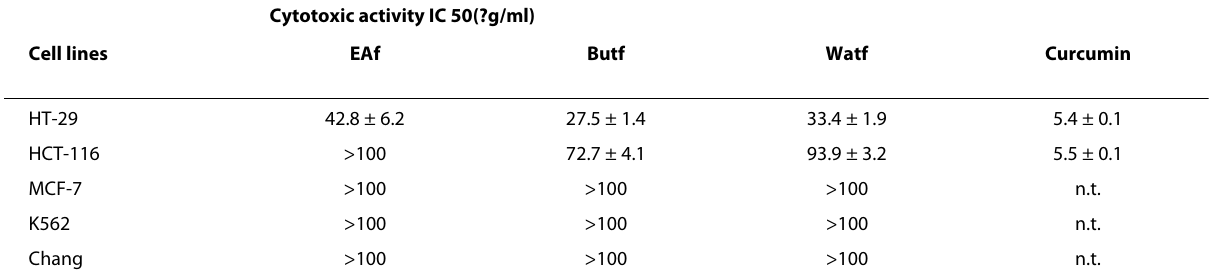
Chang >100 >100 >100 n.t.